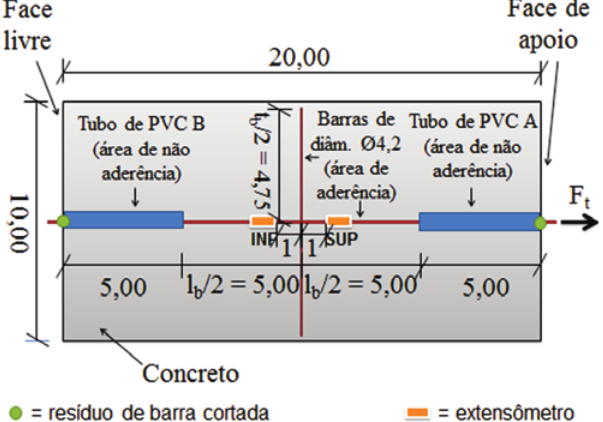
Figura 4 CP tipo "Tela" com extensômetros (corte longitudinal)